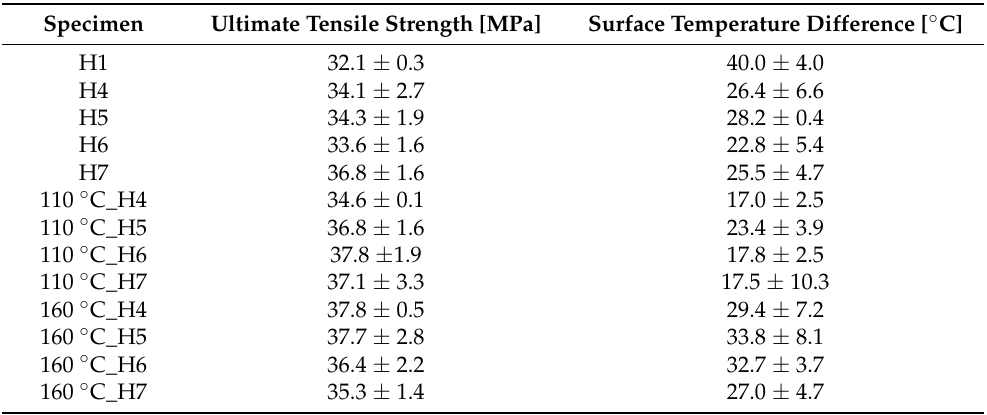
Figure 6. Deformation process of H1 evaluated using IR thermography.